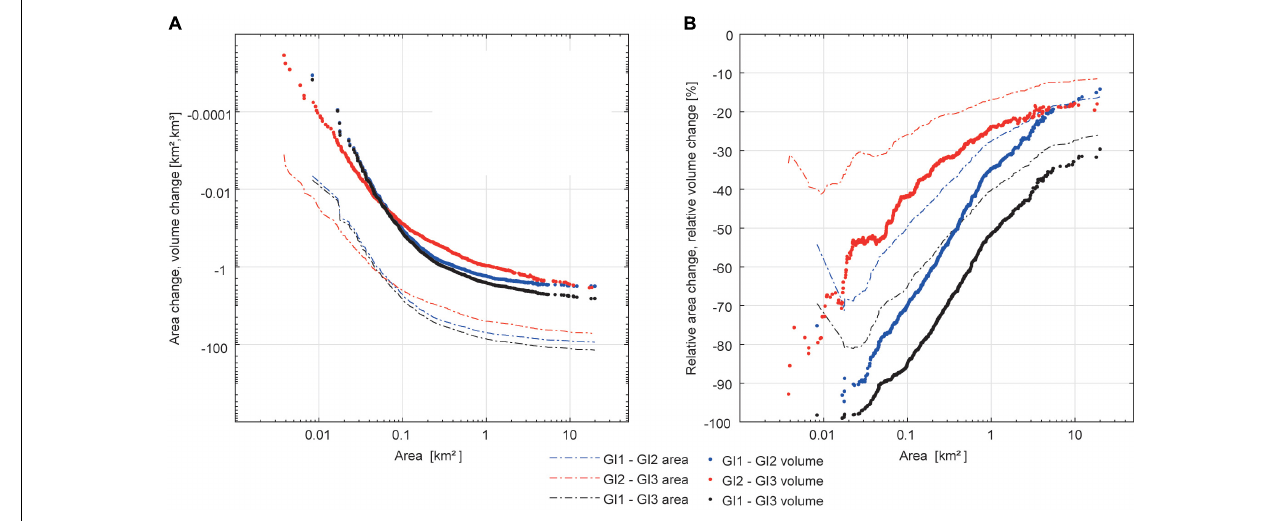
FIGURE 8 | (A) Cumulative absolute changes in area and volume and (B) cumulative changes of area and volume relative to glacier area and glacier volume between the glacier inventories (GI) for all glaciers sorted by glacier area. Note the logarithmic scale for the glacier area and absolute change values.